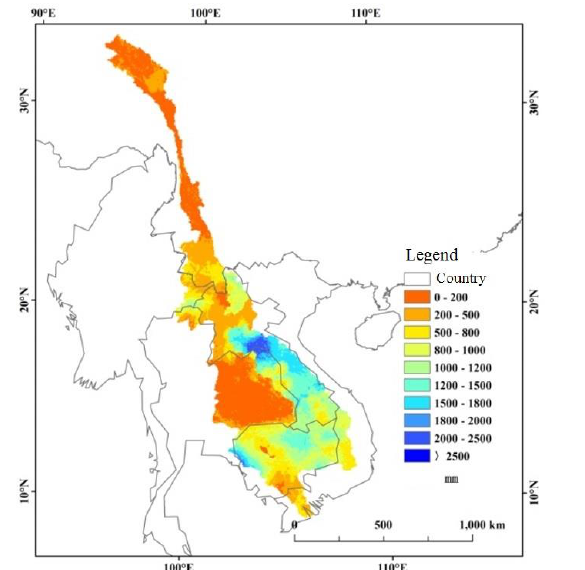
Figure 6. Runoff depth of Mekong River Basin from2013.06 to